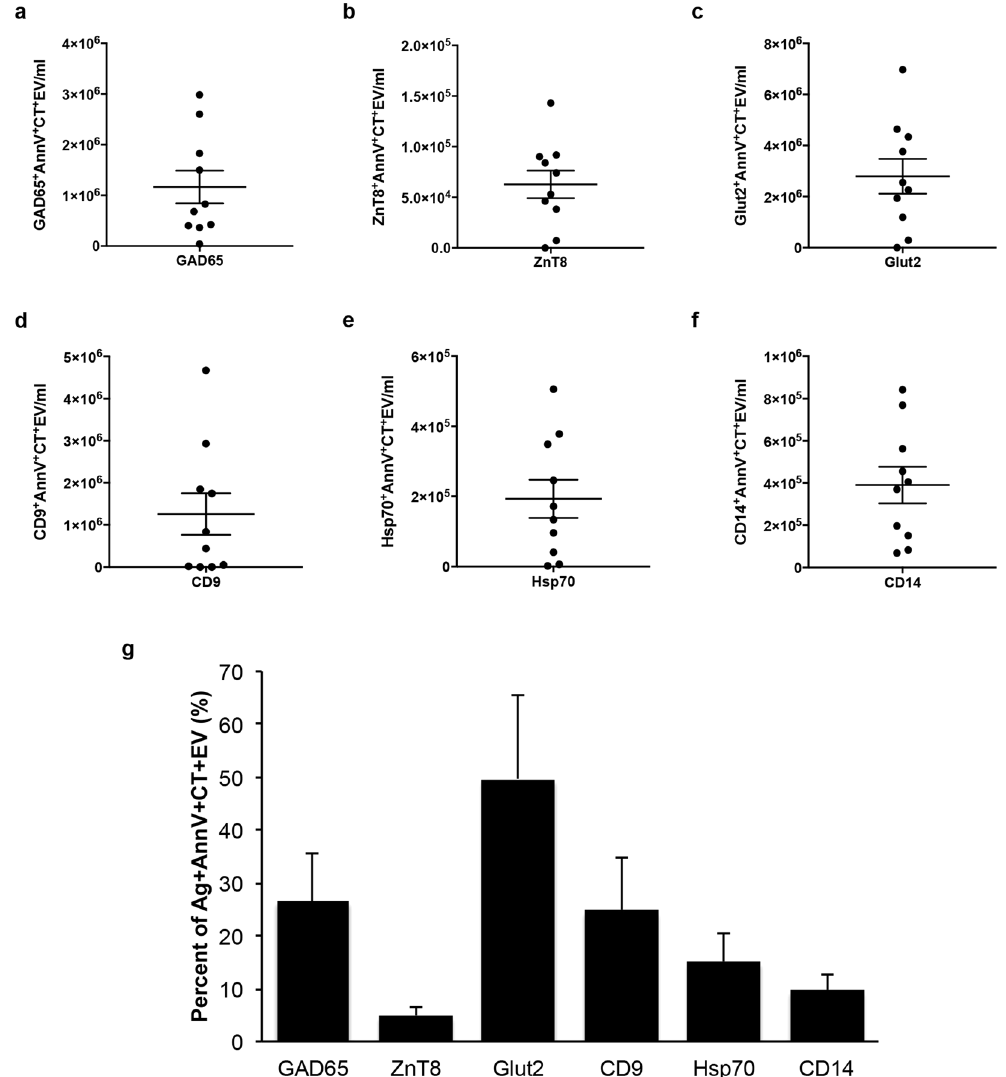
Figure 7. Antigen levels on extracellular vesicles present in islet conditioned media from different donor islet preparations. Column scatter graphs of islet conditioned media (ICM) analyzed by flow cytometry for GAD65 + AnnV + CT + EV ( a ), ZnT8 + AnnV + CT + EV ( b ), Glut2 + AnnV + CT + EV ( c ), CD9 + AnnV + CT + EV ( d ), Hsp70 + AnnV + CT + EV ( e ), and CD14 + AnnV + CT + EV ( f ). Bar graph depicting the percent of AnnV + CT + EV that were positive for the antigens described in the above panels ( g ). Data are expressed as mean ± SEM from n = 10 human islet preparations from different donors, and are representative of n = 3 independent